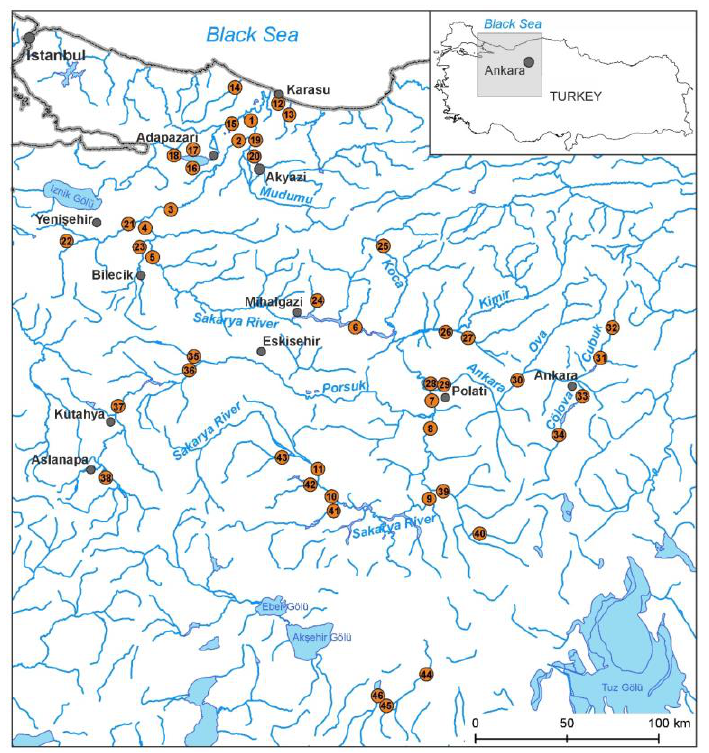
Figure 1. Location of the sampling stations (1–46) in the Sakarya River basin.